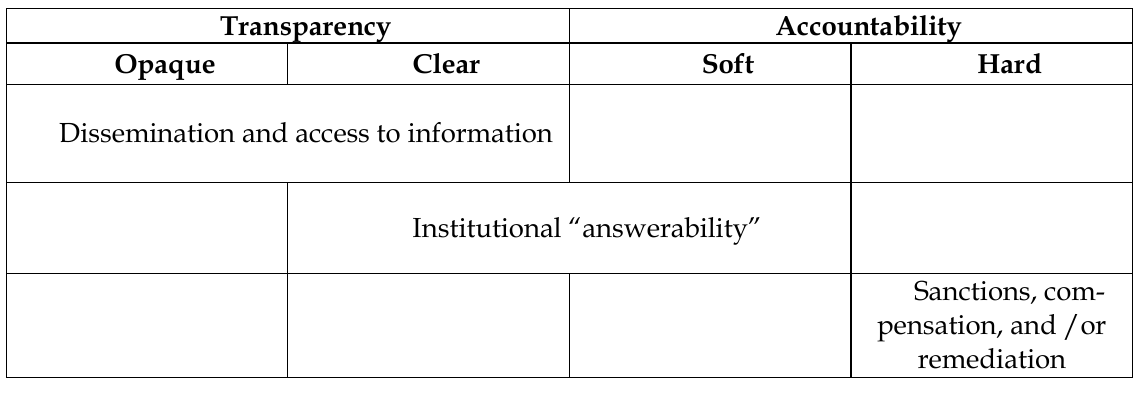
Table 1: Unpacking the Relationship between Transparency and